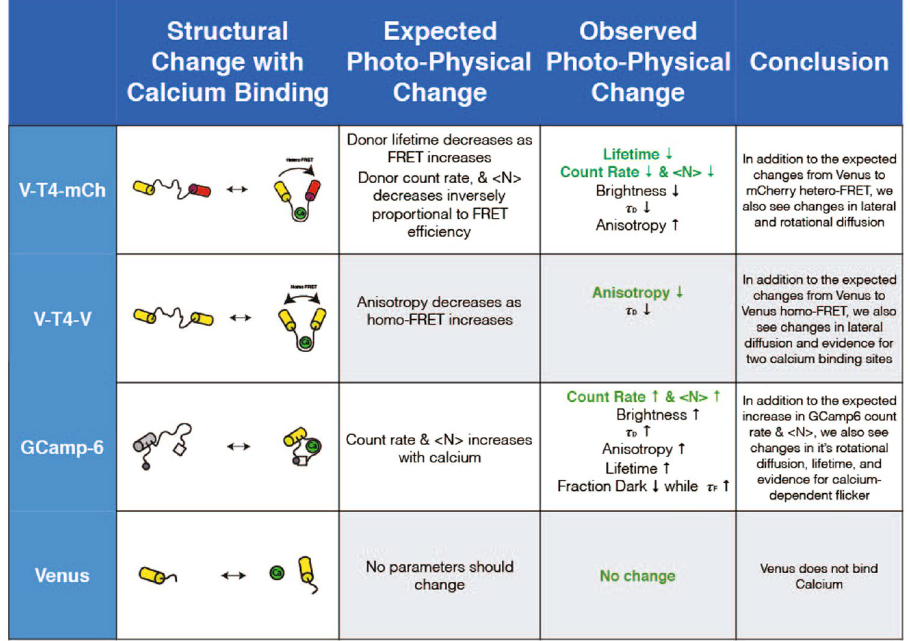
Figure 11. Data synopsis of auto-FPFA of three calcium sensors and negative control. Cartoon at left depicts the structural changes thought to occur upon calcium binding. Table depicts the expected photo-physical changes and the observed changes in the constructs